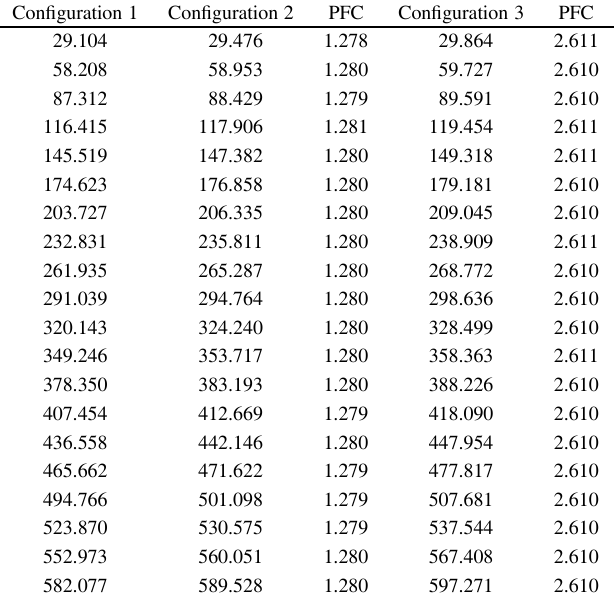
Table 23 Longitudinal natural frequencies of a radar truss for t b = 4.8